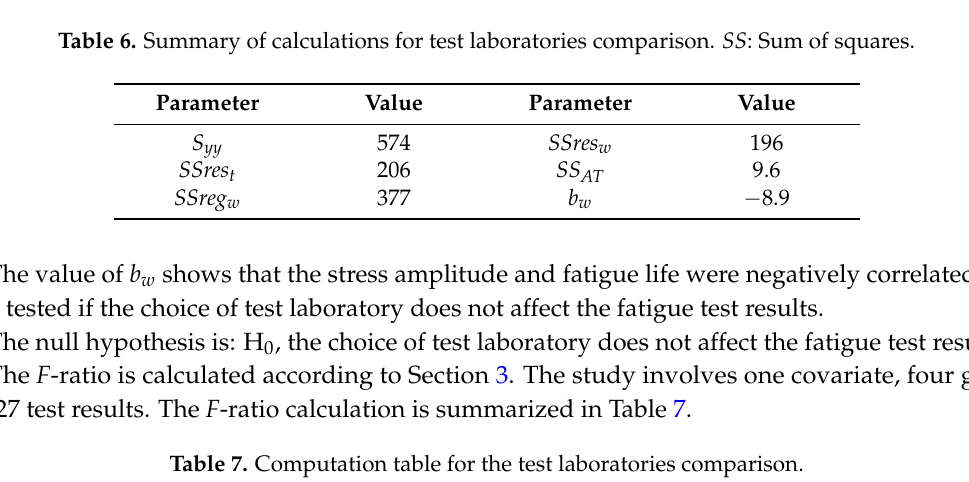
Table 7. Computation table for the test laboratories comparison.